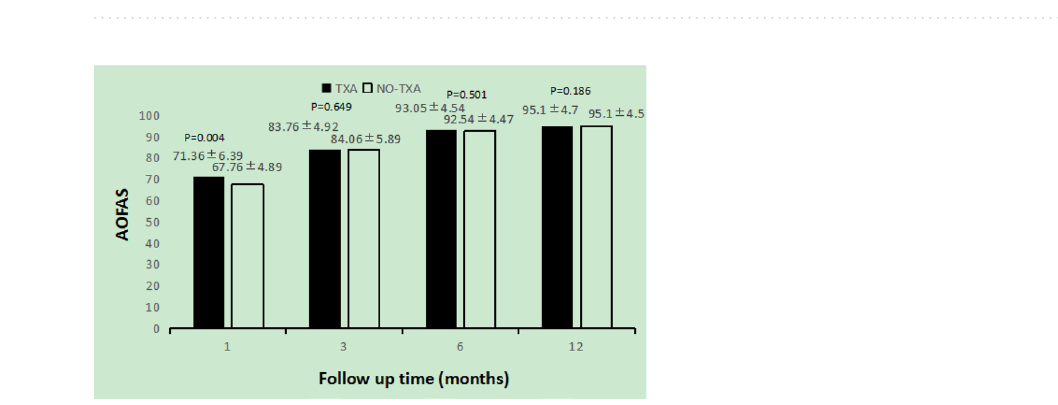
Figure 1. The average AOFAS score and ROM of preoperation between the two groups. The TXA group is shown as black bars and the NO-TXA group is shown as white bars.